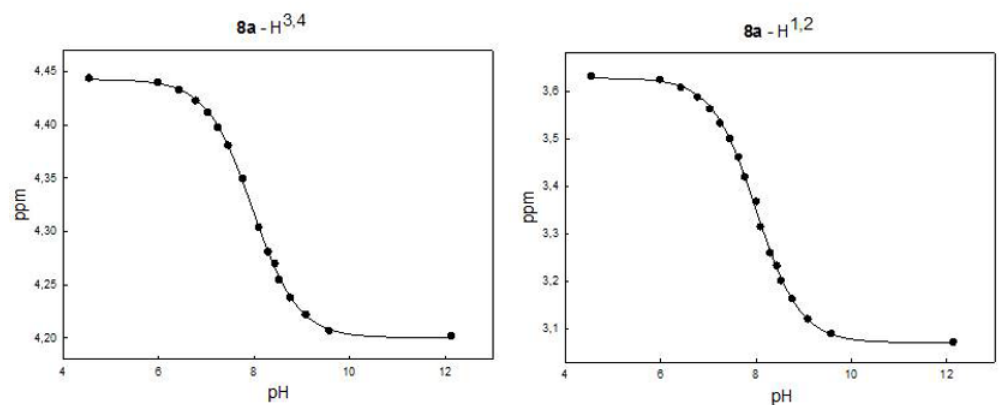
Figure 1. pH dependence of 1 H NMR shifts for compound 8a